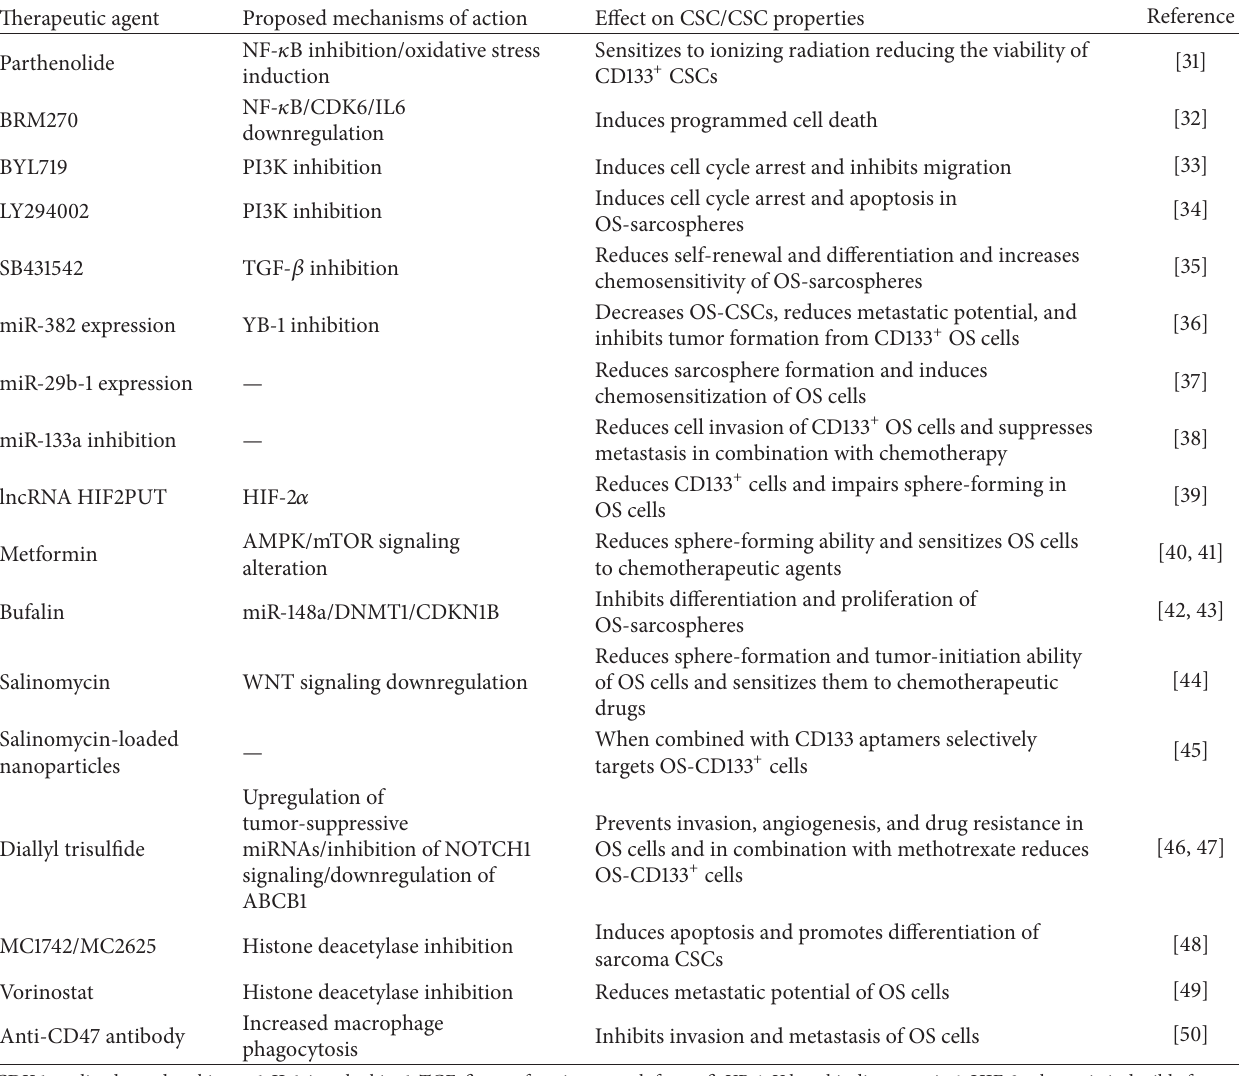
Table 2: Therapeutic agents with reported activity on OS-CSCs subpopulations or related